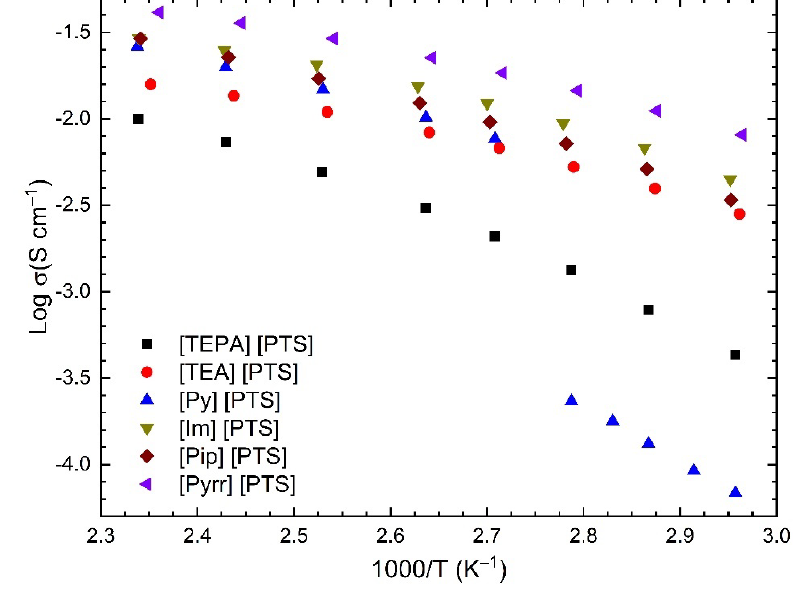
Figure 7. Log σ vs. T − 1 plots for the PILs.